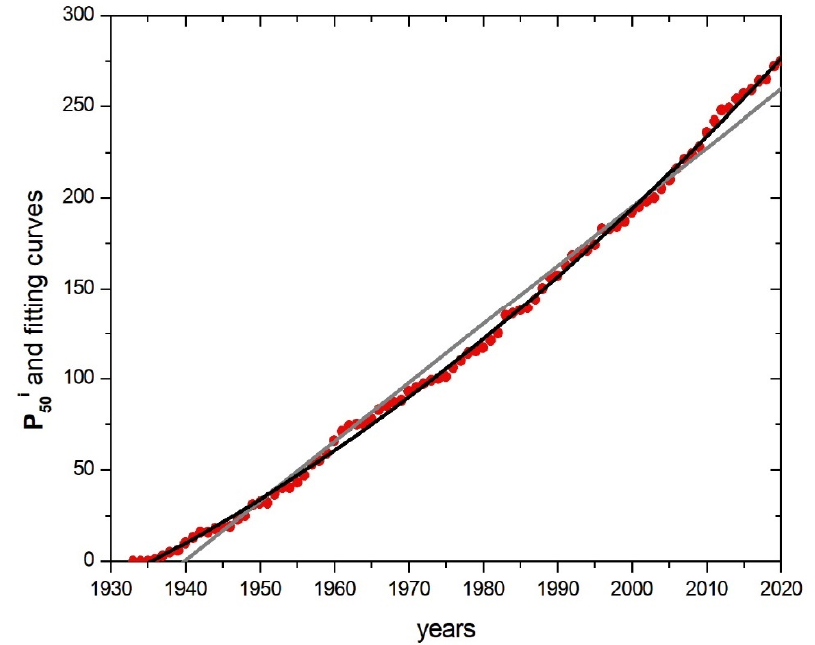
Figure 4. Annual cumulative days with precipitation higher than 50 mm (red dots). The gray line is the best linear fitting, while the black line is the best nonlinear fitting.